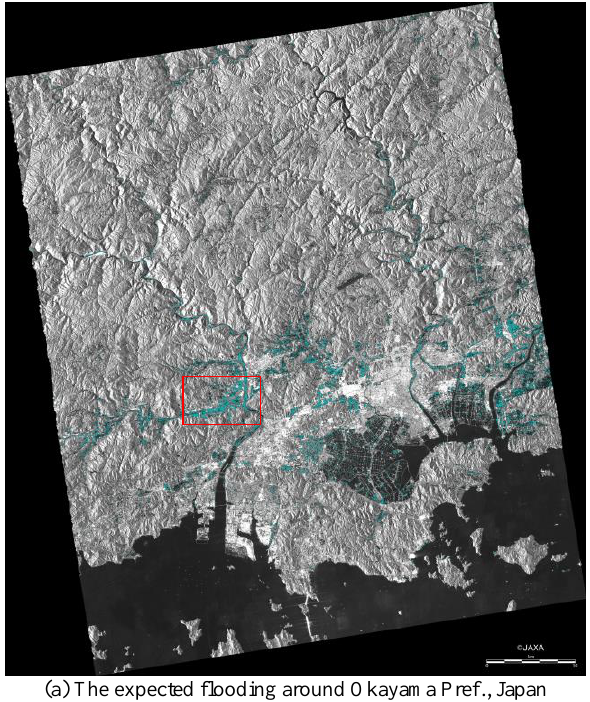
composite image (red: HV polarization on Feb. 27, 2018, green: HV on May 22, 2018, blue: HH on May 22, 2018) around seen in red color.